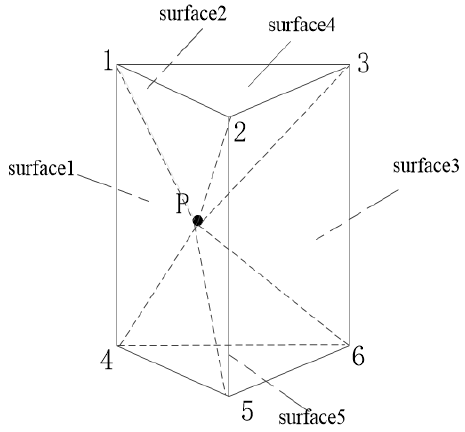
Figure 3. Nodes and surface serial numbers of the triangular prism elements.